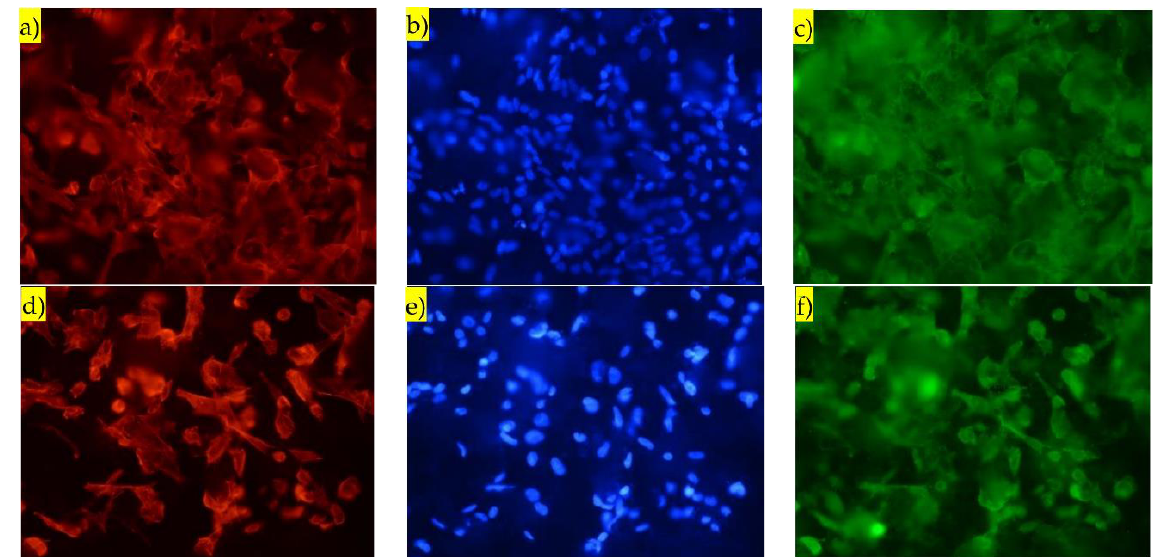
Figure 8. Immunofluorescence images obtained five days after culture. The red fluorescence indicates the cytoskeleton of the osteoblasts, the blue fluorescence indicates the osteoblasts’ nuclei and the green fluorescence indicates vinculin protein. Images ( a – c )—charged APS Hap coating; ( d – f )—non-charged APS Hap coating. The images were obtained with the 40x objective, and correspond to an area of about 330 µm × 424 µm.